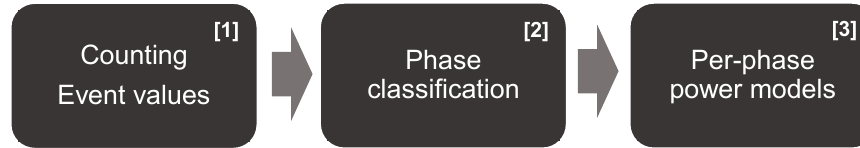
Figure 4. Overall process of the proposed GPU power model.